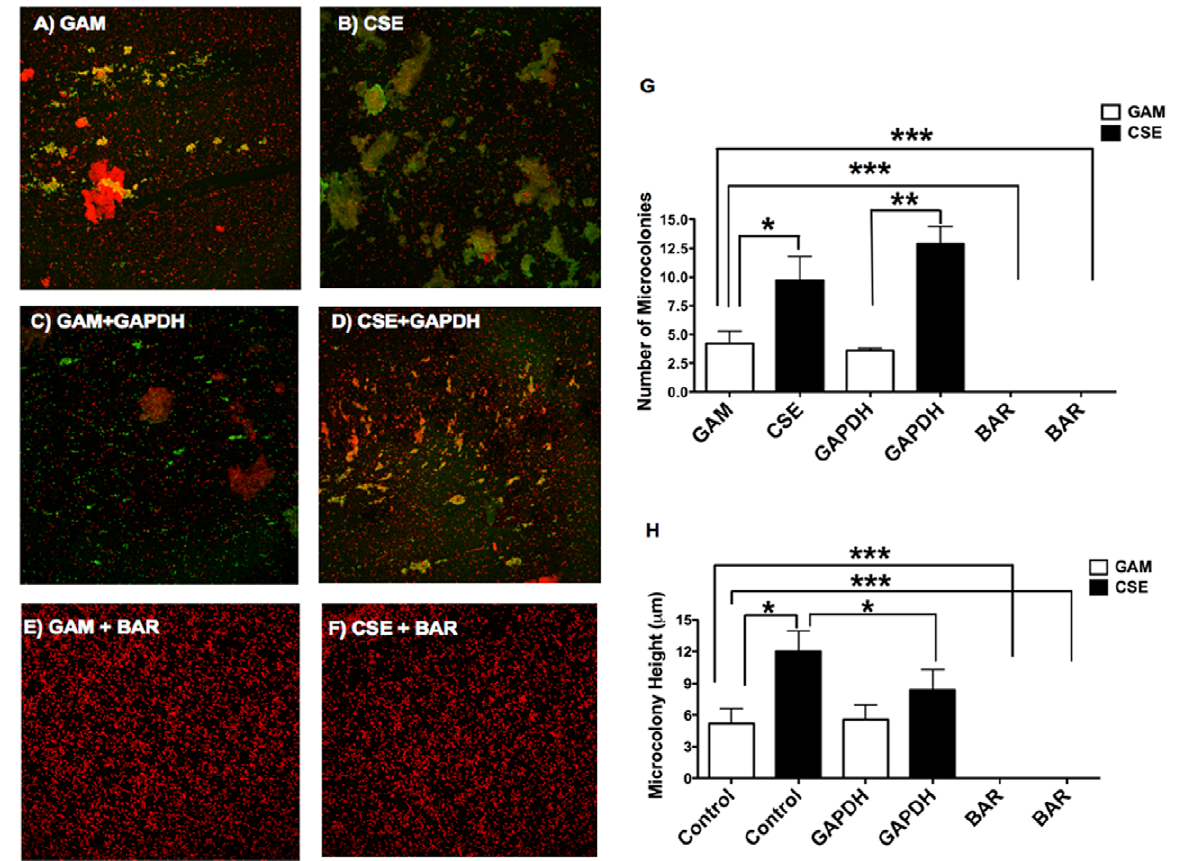
Figure 5. CSE augmentation of biofilm formation is FimA-enhanced and Mfa1-dependent. As shown previously CSE exposure significantly increased P. gingivalis association with S. gordonii (B) compared to control P. gingivalis grown in GAM (A) as reflected by total numbers of microcolonies (yellow) formed. Pre-treatment of P. gingivalis with rGAPDH (3.4 m M) reduced association (microcolony height and numbers) between CSE-exposed P. gingivalis and S. gordonii (D) but had no effect on control P. gingivalis grown in GAM (C). Pretreatment with BAR peptide (3.4 m M) completely abolished any association between S. gordonii and P. gingivalis grown either in GAM (E) or CSE (F). Total number and height of microcolonies (yellow) formed by Hexidium iodide labeled S. gordonii (red) and Alexa488 labeled P. gingivalis (green) biofilms formed in an open flow system were quantified by taking optical section along the x-y and z axis at 1 m m intervals under a confocal microscope and presented in figures (G) and (H) respectively. * p , 0.05; ** p , 0.01; *** p , 0.001.